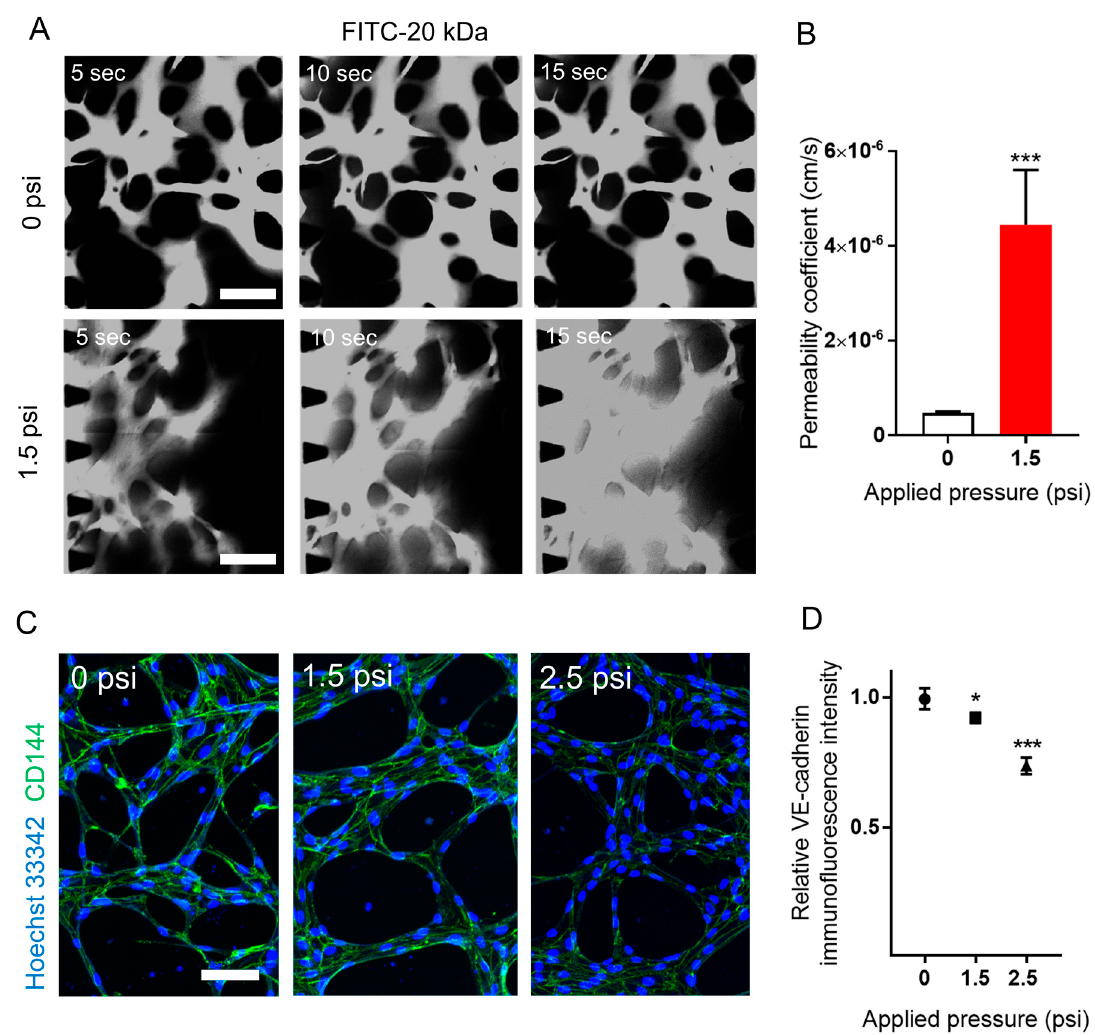
Figure 7. Vascular permeability and VE-cadherin expression di ff erences from di ff erent pressures. ( A ) FITC-dextran (20 kDa) was introduced into the microvascular network. Scale bars: 100 µ m. ( B ) Permeability coe ffi cient for two di ff erent conditions. Bars represent mean ± SEM from 4–5 devices per condition. *** p < 0.001 in an unpaired two-tailed Student’s t-test. ( C ) Confocal microscopy images of a 3D microvessel network immunostained with anti-VE-cadherin. Scale bar: 50 µ m. ( D ) Quantitative analysis of the relative VE-cadherin immunofluorescence intensity under pressures varying from 0 psi to 2.5 psi. Bars represent the mean ± SEM from 4–5 devices per condition. * p < 0.05, *** p < 0.001 in an unpaired two-tailed Student’s t